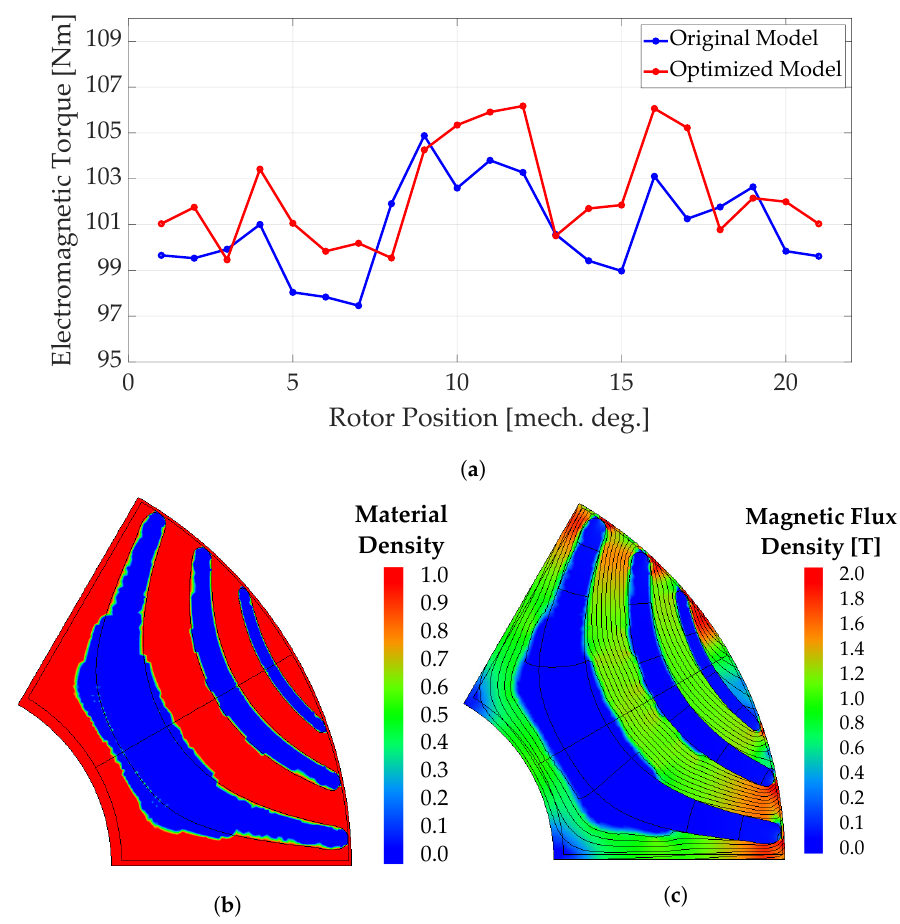
Figure 11. Optimization results starting from a non-empty design space: ( a ) Electromagnetic torque of original and optimized model, ( b ) material distribution, ( c ) flux density